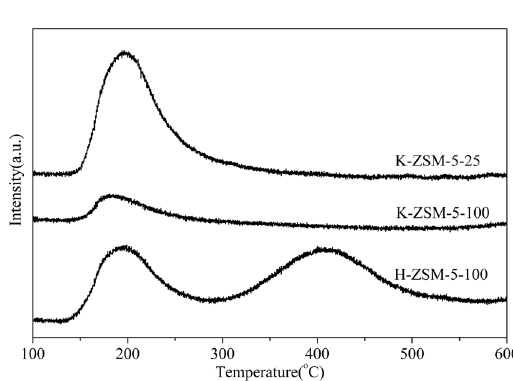
Figure 6. NH 3 -TPD profiles of the samples.